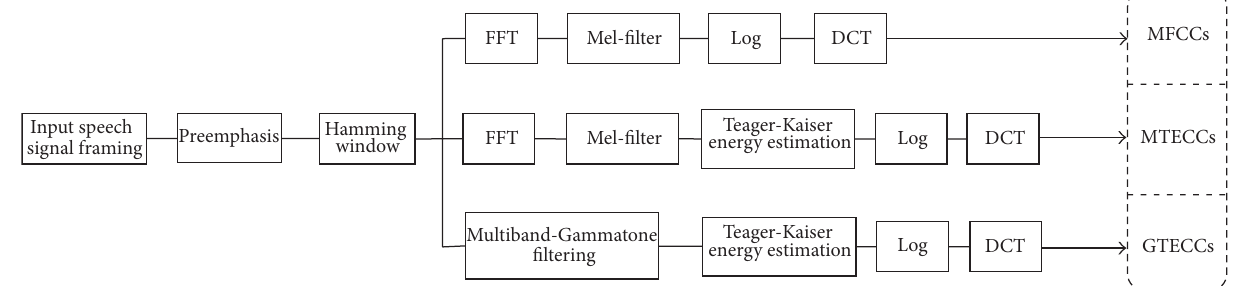
Figure 3: Block diagrams of the extraction of MFCC, MTECC, and GTECC features.